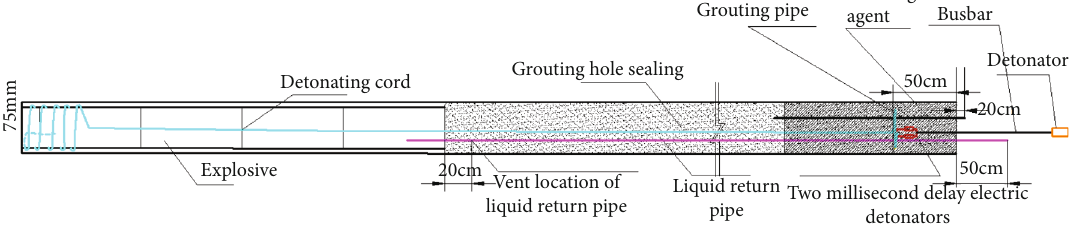
Figure 10: Schematic diagram of blasting hole charging.